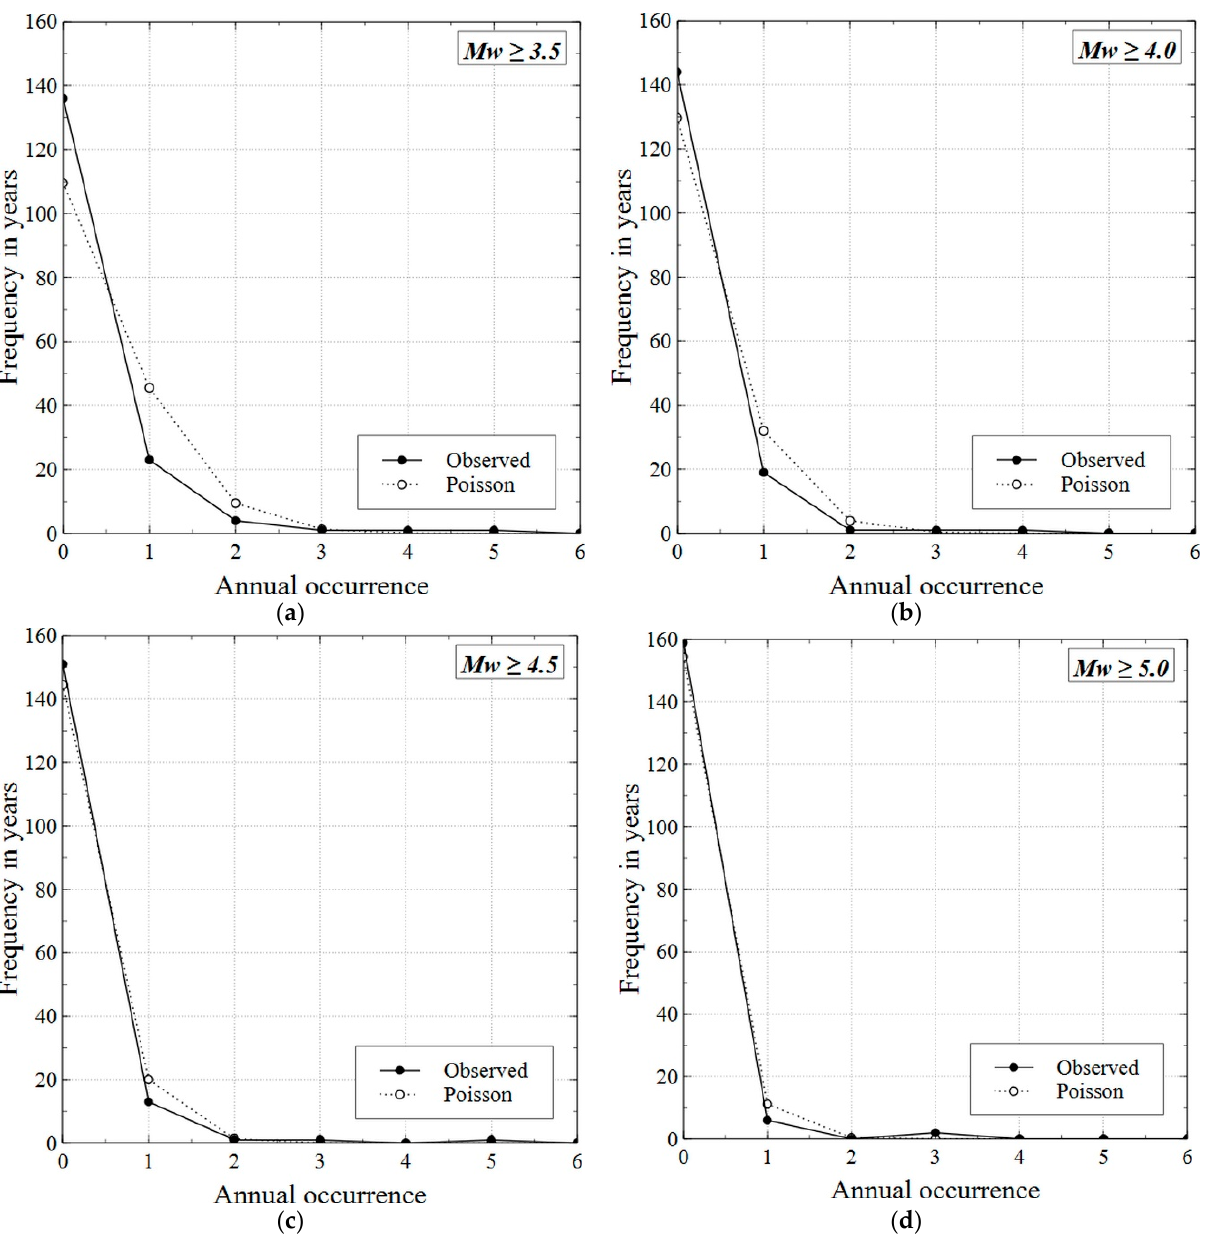
Figure 2. Comparison between the observed and the theoretical earthquake frequency occurrence for earthquakes occurring in the Banat seismic source with: ( a ) M W ≥ 3.5; ( b ) M W ≥ 4.0; ( c ) M W ≥ 4.5; ( d ) M W ≥ 5.0.